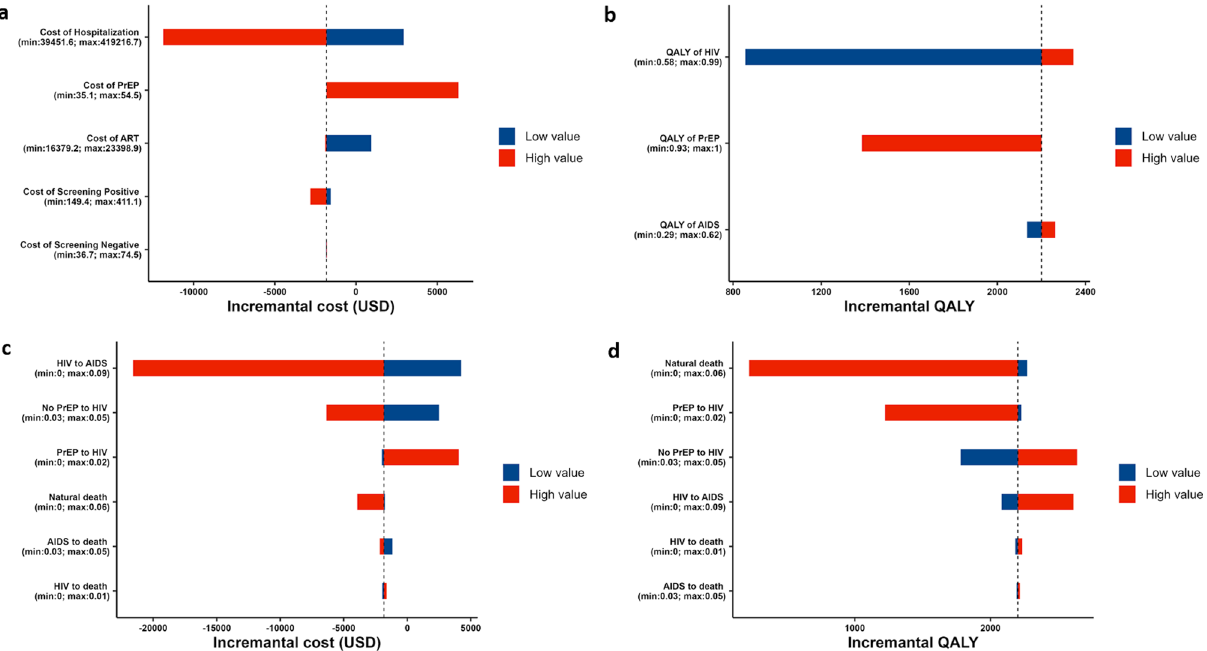
Figure 4. Cost-effectiveness evaluation of the pre-exposure prophylaxis (PrEP) program. The incremental cost and the incremental QALYs gained in the 30 years since the introduction of the PrEP program with varied parameter values was calculated. Incremental cost varying each cost, QALYs, or transition parameter. The black dashed vertical lines represent the base case scenario. Therefore, the values on the left of the base case scenario correspond to more favorable scenarios compared with baseline. Blue bars represent parameter values lower than baseline, and red bars represent parameter values higher than baseline. ( a ) Cost parameters were varied: the cost of PrEP pills, cost of hospitalization due to AIDS, cost of ART for those infected by HIV, cost of screening for the HIV-positive population, and cost of screening for the HIV-negative population. ( b ) QALY parameters varied: QALYs for people with PrEP, people living with HIV, and AIDS. ( c ) The transition probabilities of the Markov model also varied. For the transition probability from PrEP to HIV, the PrEP efficacy was